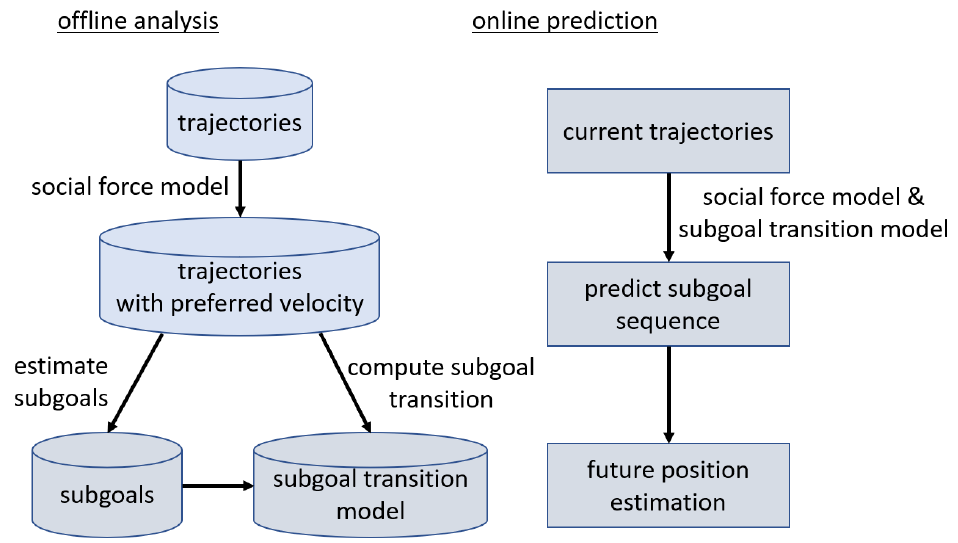
Figure 7. Overview of the approach by Ikeda et al. [50]. Image granted by